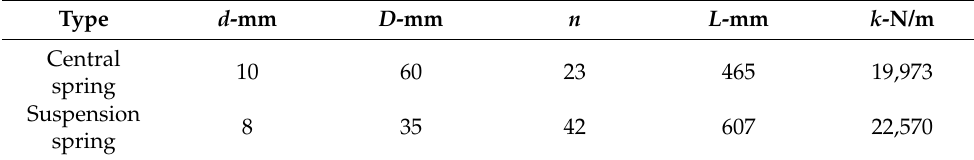
Table 3. The physical parameters of the springs.